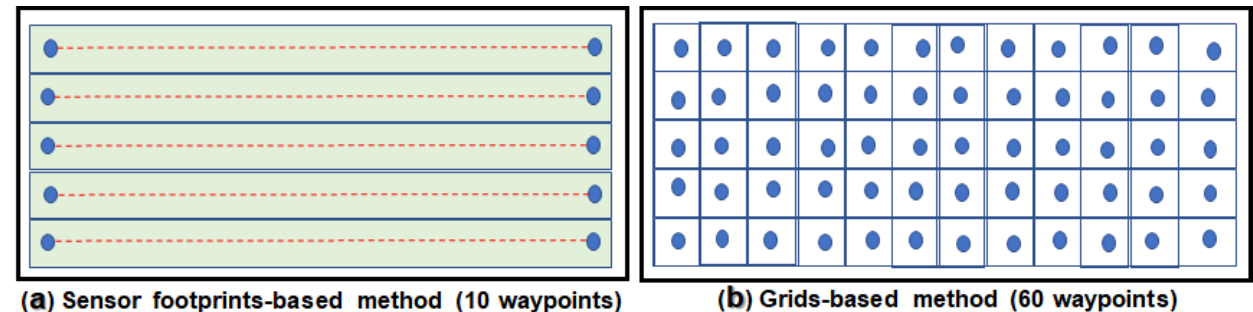
Figure 15. Number of waypoints for the proposed method ( a ) compared to the grid-based methods ( b